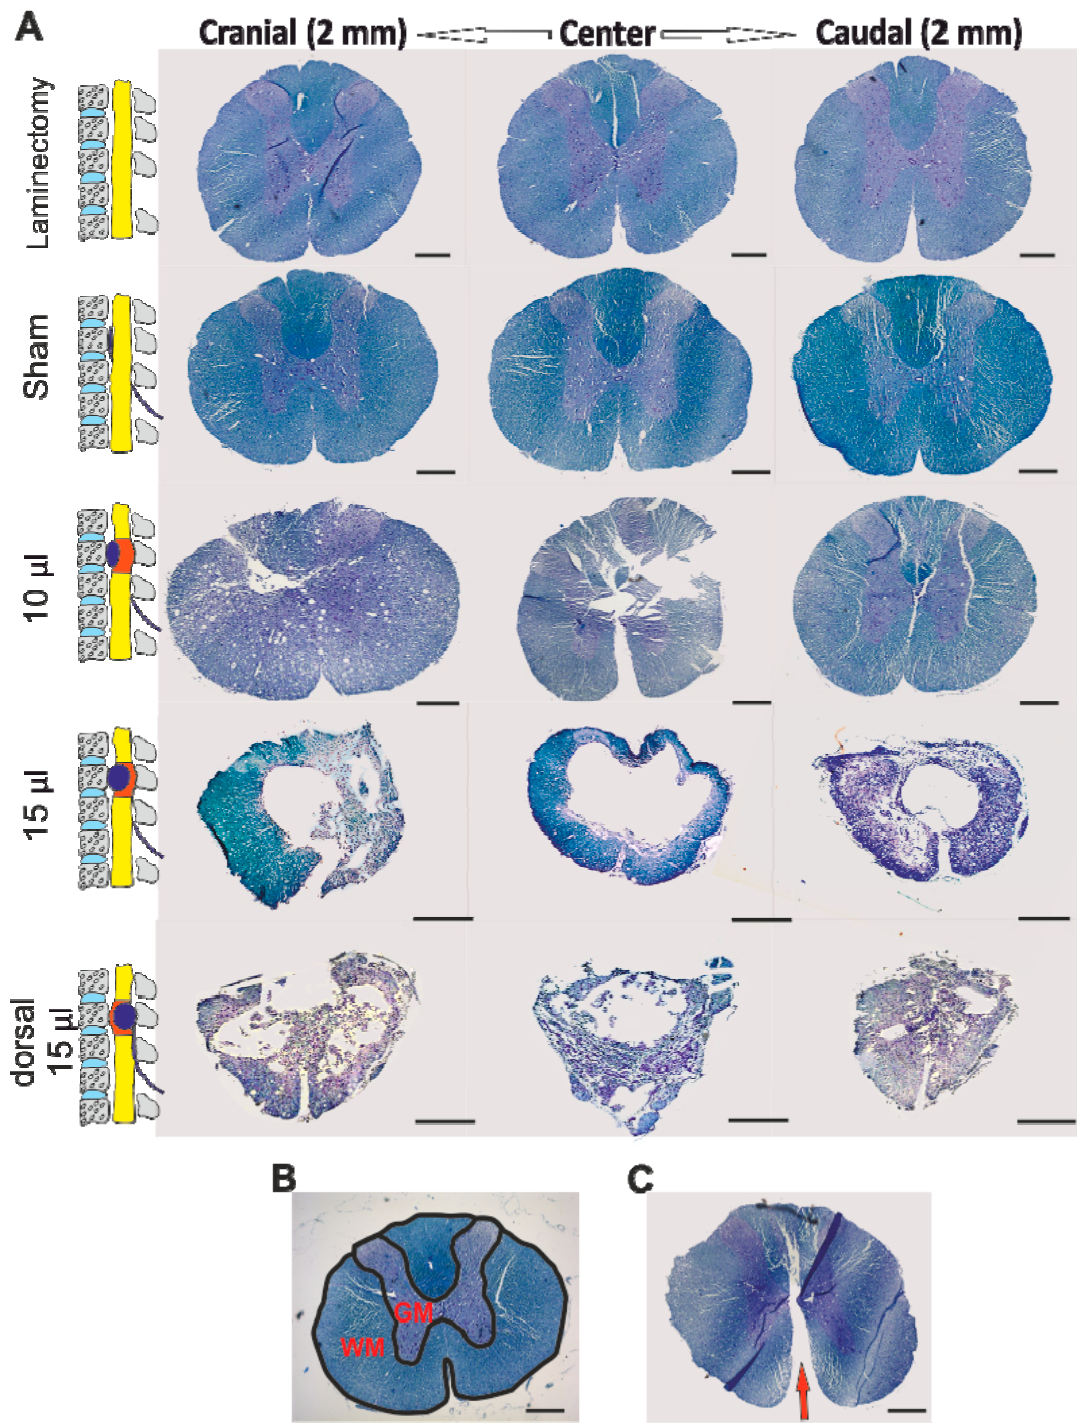
Figure 3. Histological and immunohistochemical assessment of obtained cross sections. Graded spinal cord lesion in and around the epicentre (spinal level Th8) correlated with the level of compression ( A ). Morphometry of the white and grey matter according to the histological images was performed in an area of 7 mm cranially and caudally to the lesion centre ( B ). In the group of 10 μ L, splitting of the anterior median fissure was observed - red arrow points towards the split anterior median fissure ( C ). Scale bar: 500 μ m.